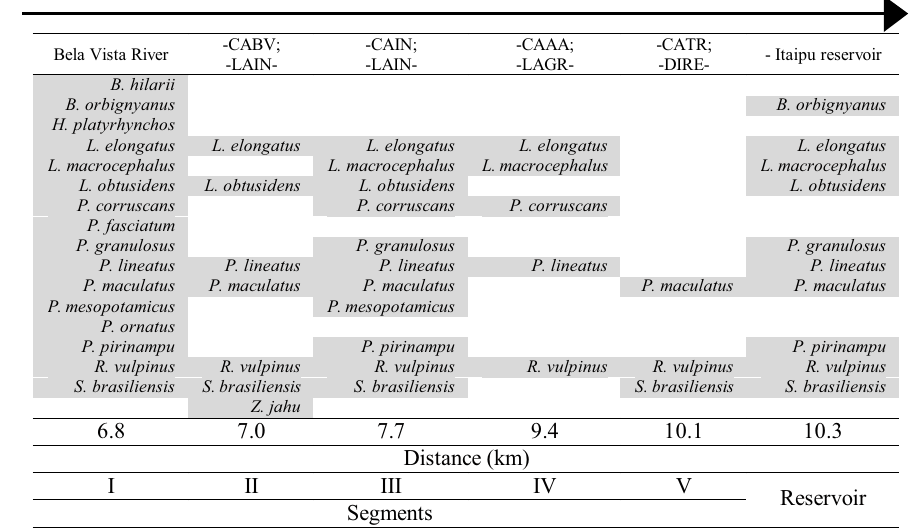
Table 2. Distribution of the long distance migratory species along the Canal da Piracema, by segment and distance (km) from the Paraná River.